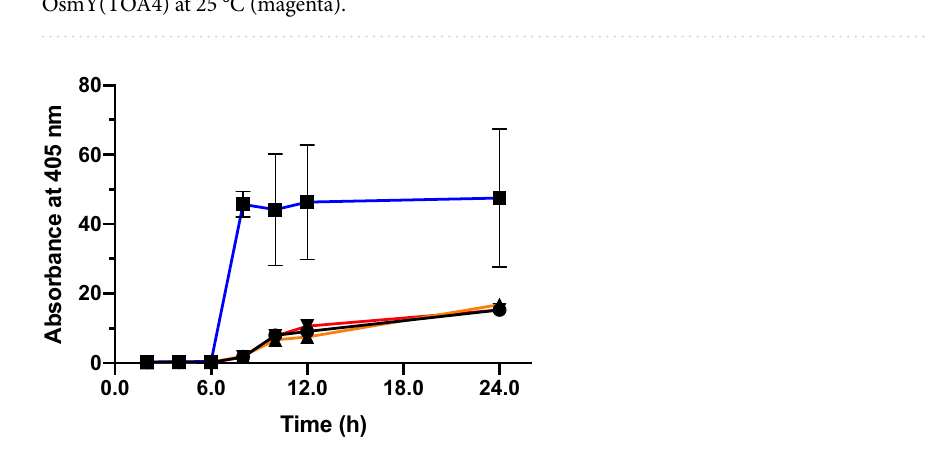
Figure 3. Characterization of improved OsmY variants in 50-mL flask cultures. The OsmY-Tfu0937 activity, measured with the pNPG assay using an absorbance at 405 nm (left axis), are plotted as bars. The cell optical densities monitored at 600 nm (right axis) are shown as symbols. Cultures were inoculated using 1:100 dilution. ( a ) OsmY(WT) and variants were expressed using C41(DE3) in 2 × TY auto-induction media and at 37 °C and 200 rpm. The bars and symbols of the variants are represented using different colours; OsmY(WT) (black), OsmY(V43A) (blue), OsmY(S19C) (orange) and OsmY(TOA4) (red). Experiments were performed in triplicate. ( b ) OsmY(WT)-Tfu0937 and OsmY(TOA4)-Tfu0937 were expressed using C41(DE3) in 2 × TY auto-induction media, at 30 °C or 25 °C, and 200 rpm. The bars and symbols of the sample are represented using different colours; OsmY(WT) at 30 °C (black), OsmY(TOA4) at 30 °C (red), OsmY(WT) at 25 °C (grey), OsmY(TOA4) at 25 °C (magenta).